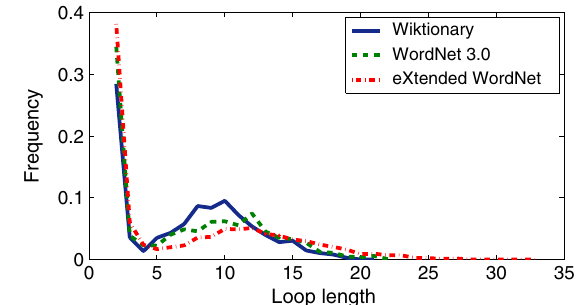
FIG. 4. Distribution of definitional loops for several diction- aries. Both the Wiktionary and WordNet 3.0 graphs are con- structed by considering only the first sense of a word in the event of polysemy. However, in WordNet, the ordering of senses is determined empirically according to usage frequencies in written texts, while in Wiktionary, the ordering of senses is determined somewhat arbitrarily, with the definition page as a whole repre- senting a general consensus of users.